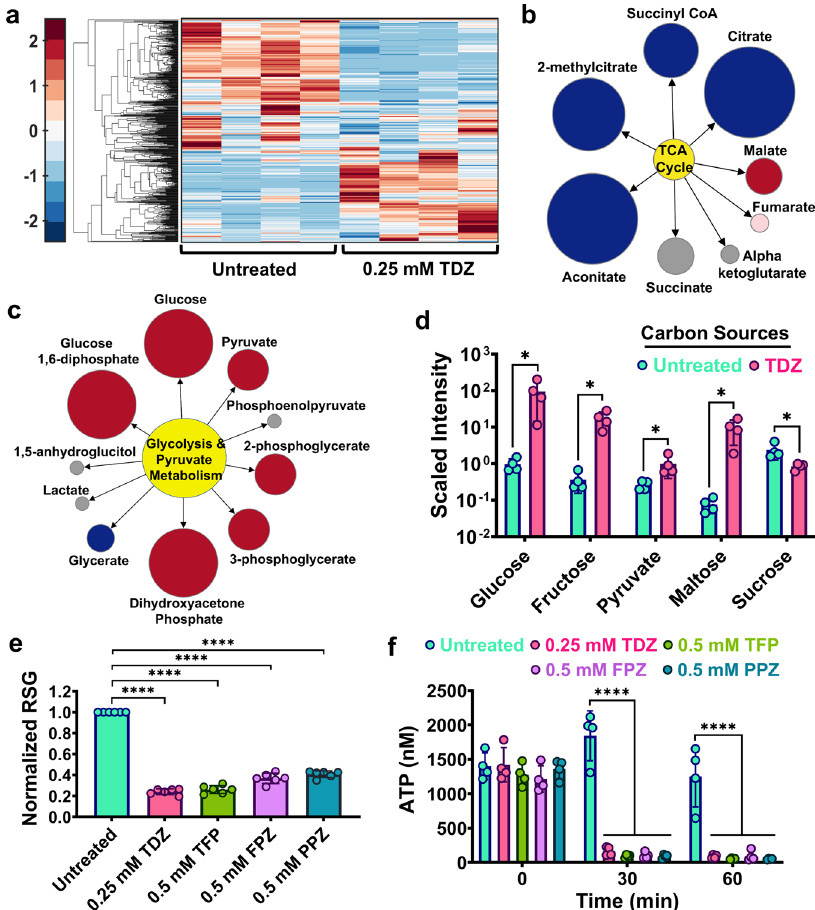
Fig. 5 Phenothiazine drugs reduced energy metabolism in E. coli MG1655. a Mass spectrometry analysis of TDZ-treated and control cells. E. coli MG1655 cells grown in LB were treated with 0.25 mM TDZ in early stationary phase ( t = 5 h) for 20 h. After treatment, cells were collected and analyzed by mass spectrometry. Unsupervised hierarchical clustering was performed on the metabolic data. The data was standardized across all samples for each metabolite to obtain a mean value of 0 and a standard deviation of 1. Color codes show how a data point deviates from the mean value. Each column represents a biological replicate. n = 4. b , c Pathway enrichment maps. Metabolites of the TCA cycle and glycolysis from TDZ-treated cells were compared to those of untreated cells. The circle size is proportional to the ratio of the normalized intensities of metabolites between TDZ-treated and untreated cells. Blue ( P ≤ 0.05) and red ( P ≤ 0.05 for dark red; 0.05 < P < 0.10 for light red) colors represent the metabolites that are signi fi cantly upregulated (red) or downregulated (blue) in the treatment group compared to the control. Gray indicates that there was no signi fi cant difference between the groups. n = 4. d Relative amounts of carbon source metabolites in the treatment and control groups obtained from mass spectrometry analysis. n = 4. e RSG staining of phenothiazine-treated cells. Early stationary phase cells ( t = 5 h) were treated with phenothiazines for 20 h and then stained with RSG prior to analysis by fl ow cytometry. The mean fl uorescence intensity of each treatment group was normalized to that of the control (untreated) group. n = 6. f ATP levels in phenothiazine-treated cells. Early stationary phase cells ( t = 5 h) were treated with phenothiazine drugs at indicated concentrations and 100 μ l of cell cultures were collected to measure ATP concentrations after 30 and 60 min. n = 4. Statistical analysis for panels a , b , c , and d was performed using Welch ’ s t-test. Statistical analysis for panels e and f was performed using One-way ANOVA with Dunnett ’ s post-test. * P < 0.05 and **** P < 0.0001. Data corresponding to each time point represent mean value ± standard